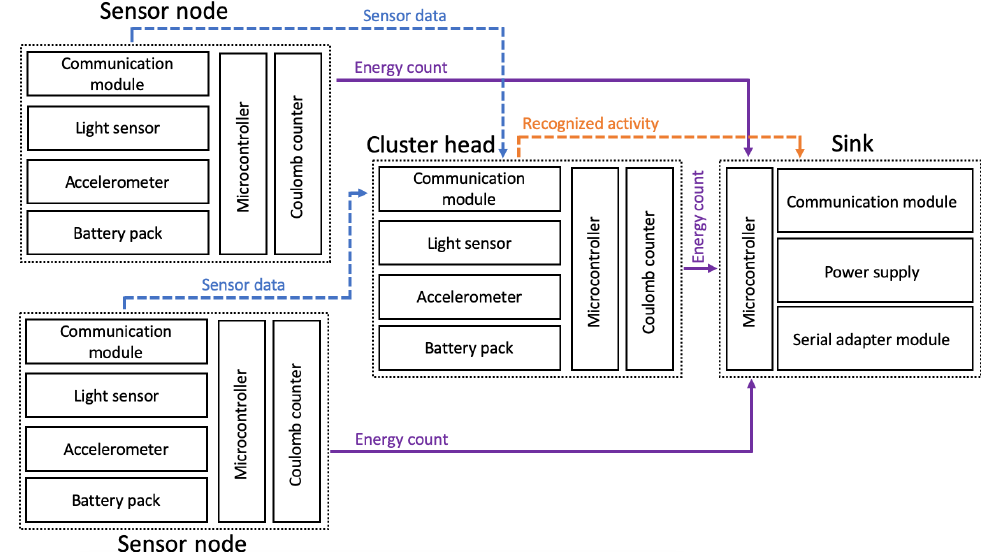
Figure 5. Block diagram of the experimental testbed.